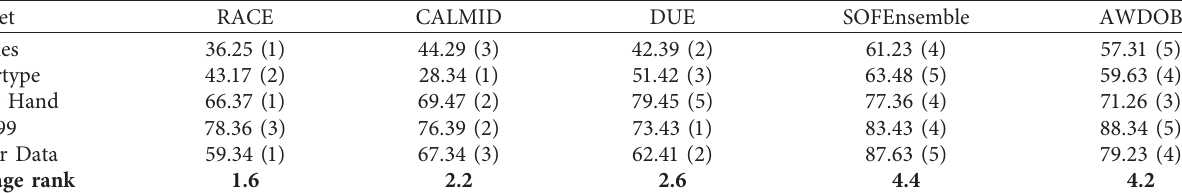
Table 9: Memory consumption of the five algorithms on real-world datasets.